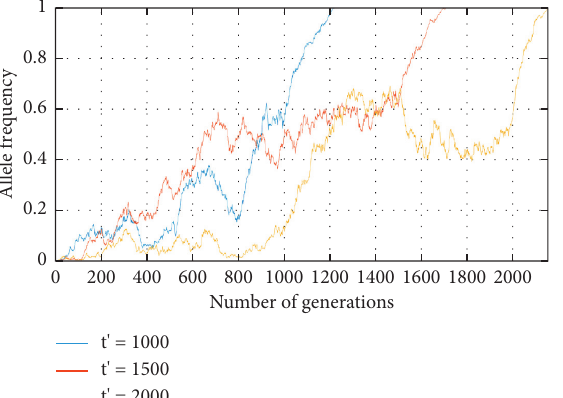
Figure 7: Evolution of the frequency of the focal allele A in the population, starting from a single mutant in a spatial grid with migration 1 between neighboring patches, with a silence interval of 1000, 1500, and 2000